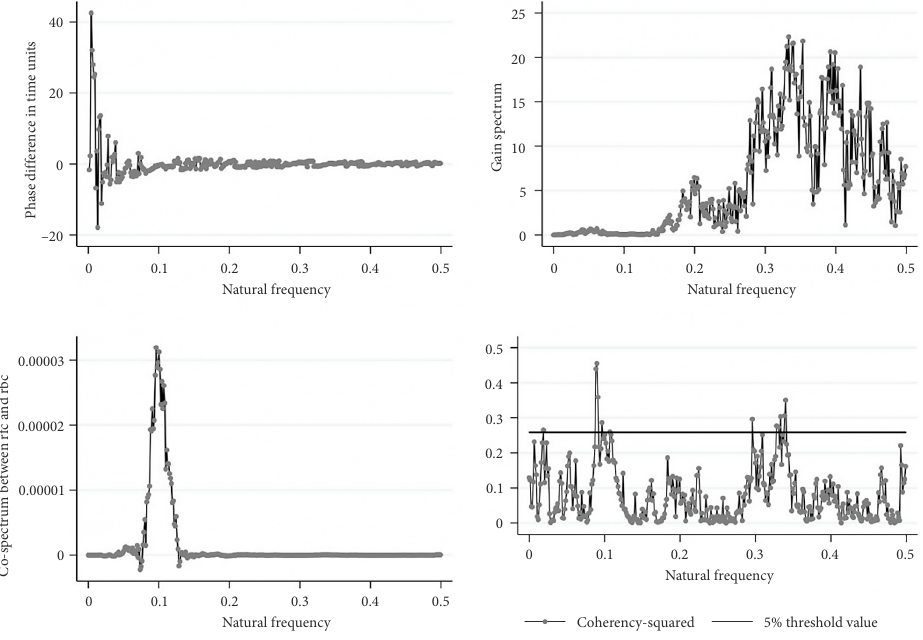
Figure 4. Cross spectral analysis of financial and business cycles in the UK 1270–2016 (source: Authors’